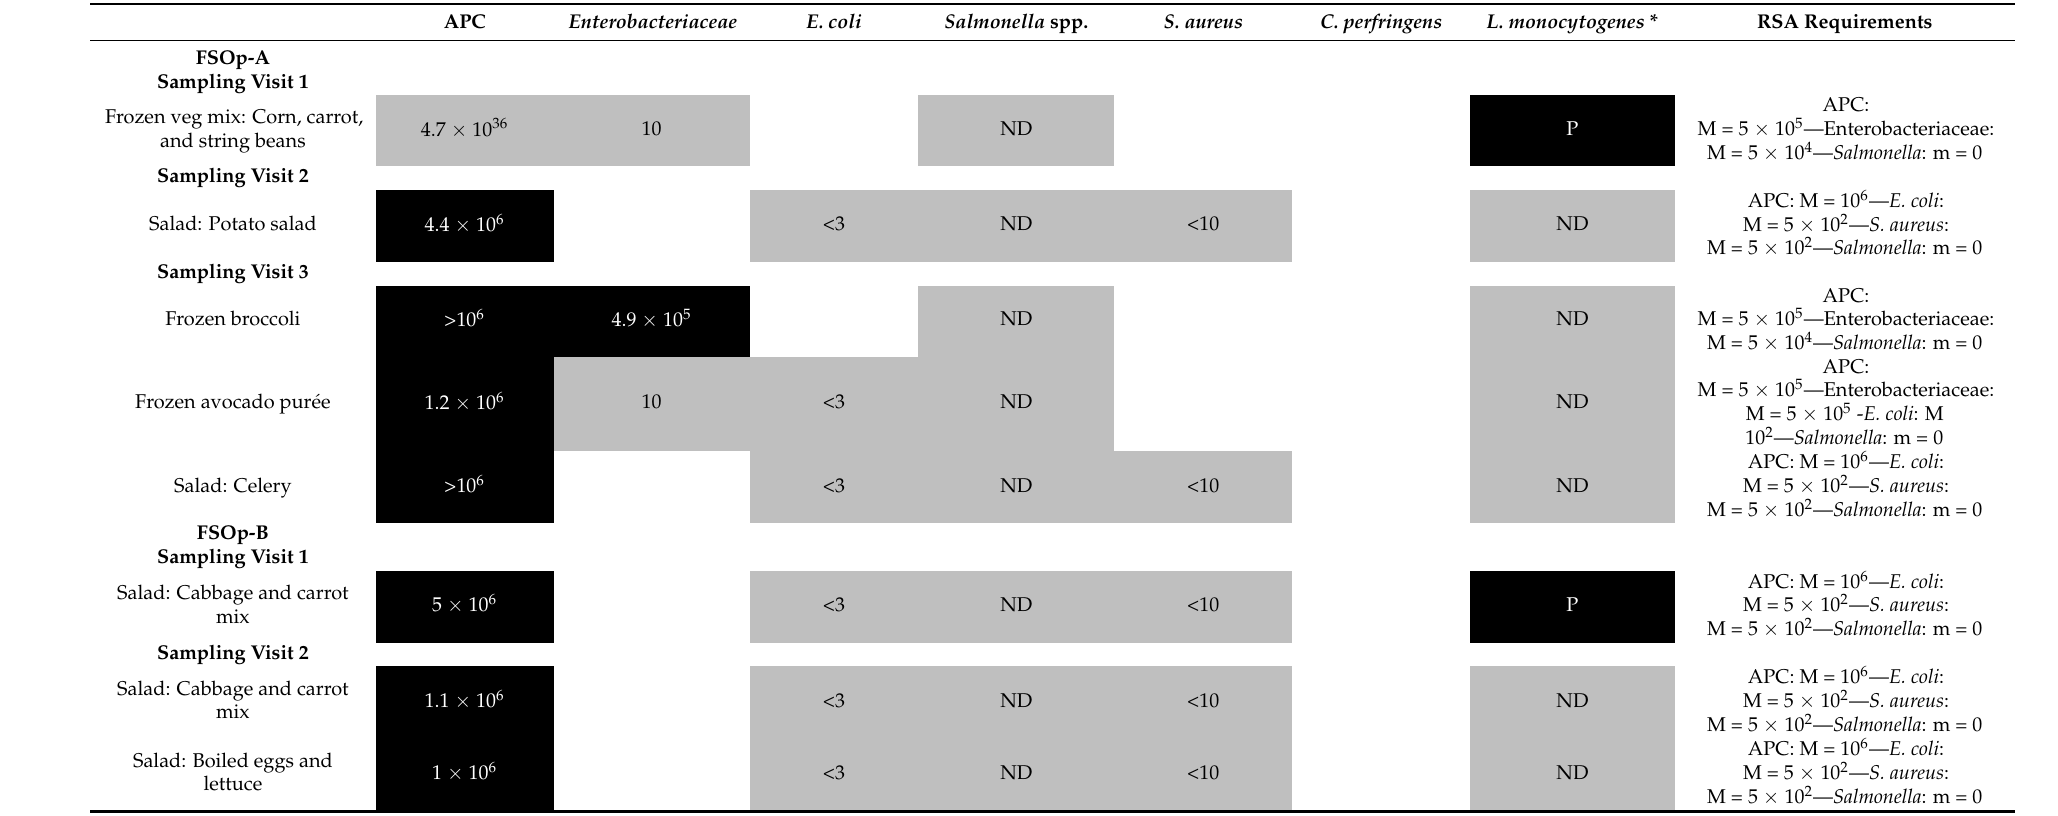
Table 2. Results of the microbiological analysis of food samples belonging to food services operations A and B. The parameters analyzed for each sample were defined according to Chilean Food Regulation (RSA). Grey squares indicate that the sample meets the level or the absence of the microorganism. Black squares indicate that the food sample exceeds the parameter level required by the RSA or indicate the microorganism’s presence (Food Standards Chile, 2019 [34]). White squares indicate parameters not tested, and the regulation does not require its testing. Numbers inside black or grey squares indicate the level found in the sample for each parameter.